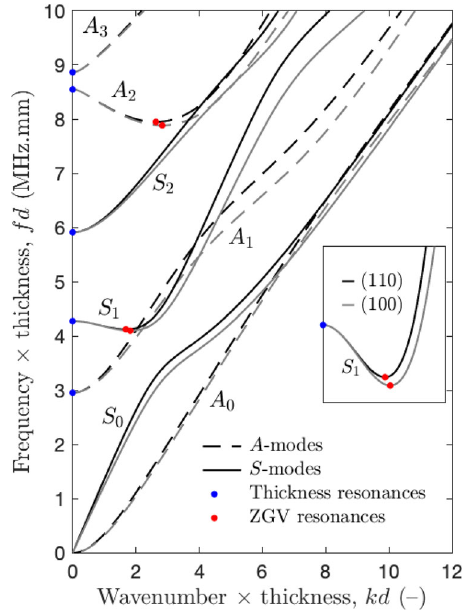
Fig. 7 Calculated elastic guided modes for bulk silicon. Dispersion curves in the normalised ( kd , fd )-plane for elastic guided waves propagating in a bulk silicon plate of thickness d along the [100]-axis (grey lines) and the [110]-axis (black lines). Red and blue dots correspond to zero group velocity (ZGV) and thickness resonance frequencies, respectively (the insert displays the frequency-dependent behaviour of ZGV in anisotropic